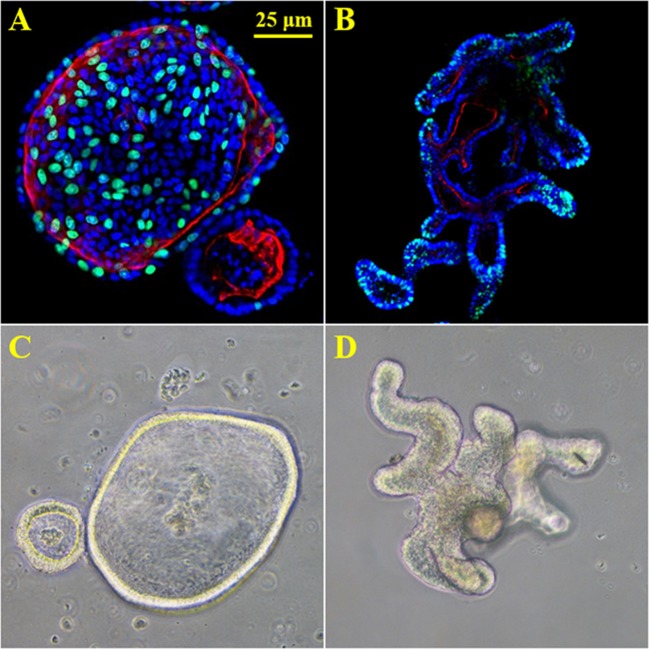
3D enteroids from human and mouse biopsy samples. (A) proliferation stain Edu (green), nuclei (blue) and f-actin (red) in human duodenal organoids. (B) proliferation stain Edu (green), nuclei (blue) and f-actin (red) in murine duodenal organoids. (C) 20X brightfield image of human duodenal organoids. (D) 20X brightfield image of murine duodenal organoids.